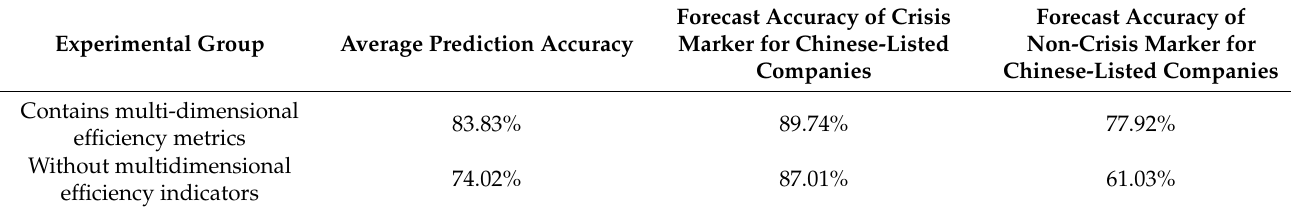
Table 12. The results of PSO–SVM prediction